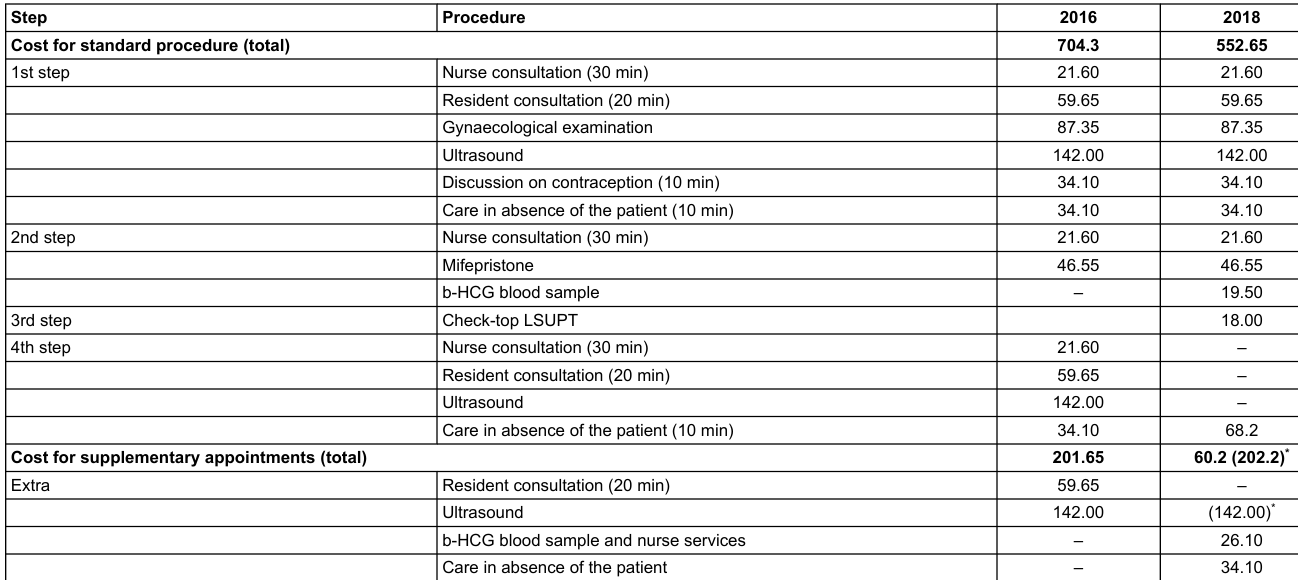
Table 1: Cost of all visits related to medical termination of pregnancy (in